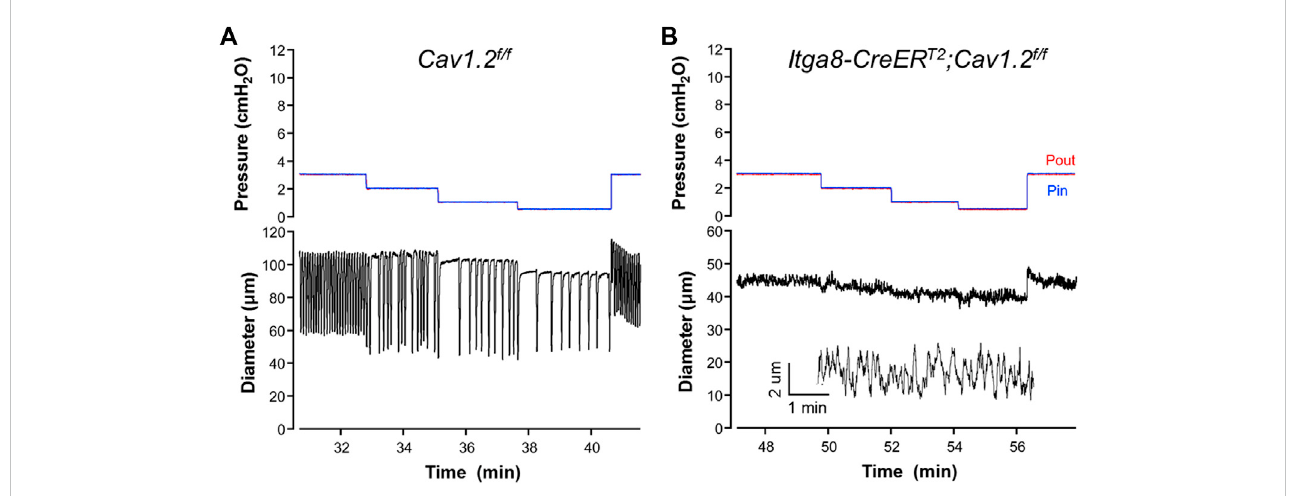
FIGURE 3 Representative recordings of contractile activityof popliteal lymphatic vesselsfrom (A) a Cav1.2 f/f mouse and (B) a Itga8CreER T2 ;Cav1.2 f/f mouse. Pinand Pout were kept at equivalent levels throughout the protocols to avoid any net changes in fl ow. The inset in (B) is an expanded section of the diameter trace at pressure = 3 cmH 2